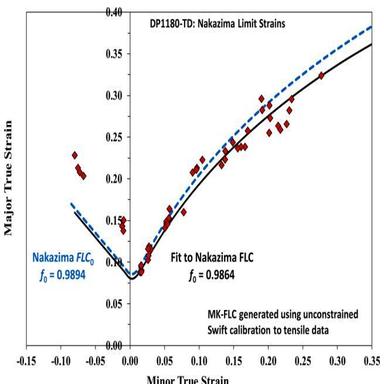
Comparison of the Nakazima limit strains for DP1180 and the MK-FLC with the unconstrained Swift model and von Mises plasticity. The imperfection factor was calculated using the Nakazima FLC0 and in a best-fit approach using all of the Nakazima data.